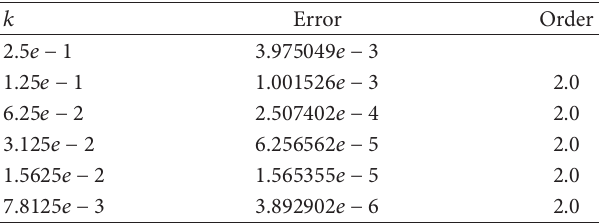
Table 3: Test Problem 3. Error and numerical convergence order. 𝑇 = 1